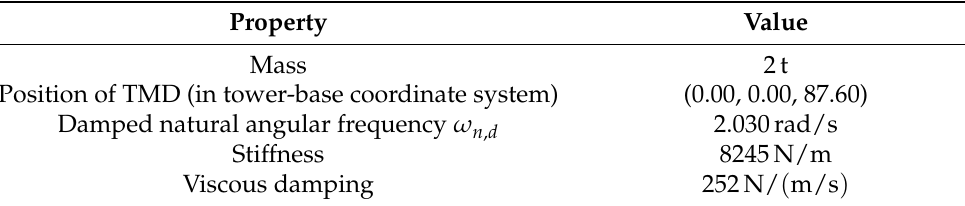
Table 3. Properties of TMD for NREL 5MW reference wind